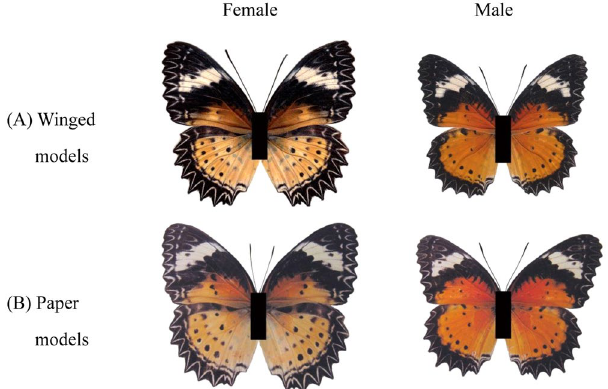
Figure 7. The winged and printed paper models of male and female Cethosia cyane cyane